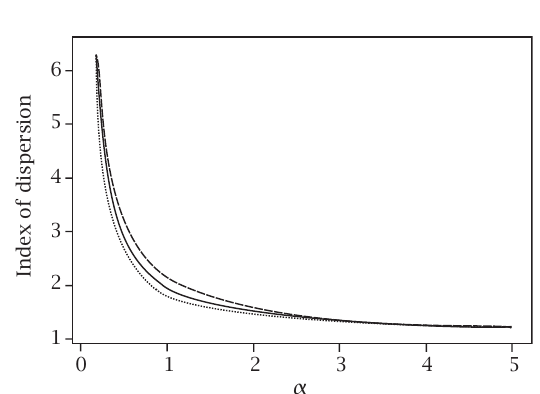
Figure 3.1 . The index of dispersion of the HGNB (α,a,p) distribution when (a,p) ≡ (a,a) ( − ) , ( 1 , 2 ) ( ··· ) , ( 2 , 1 ) ( −−− ) .